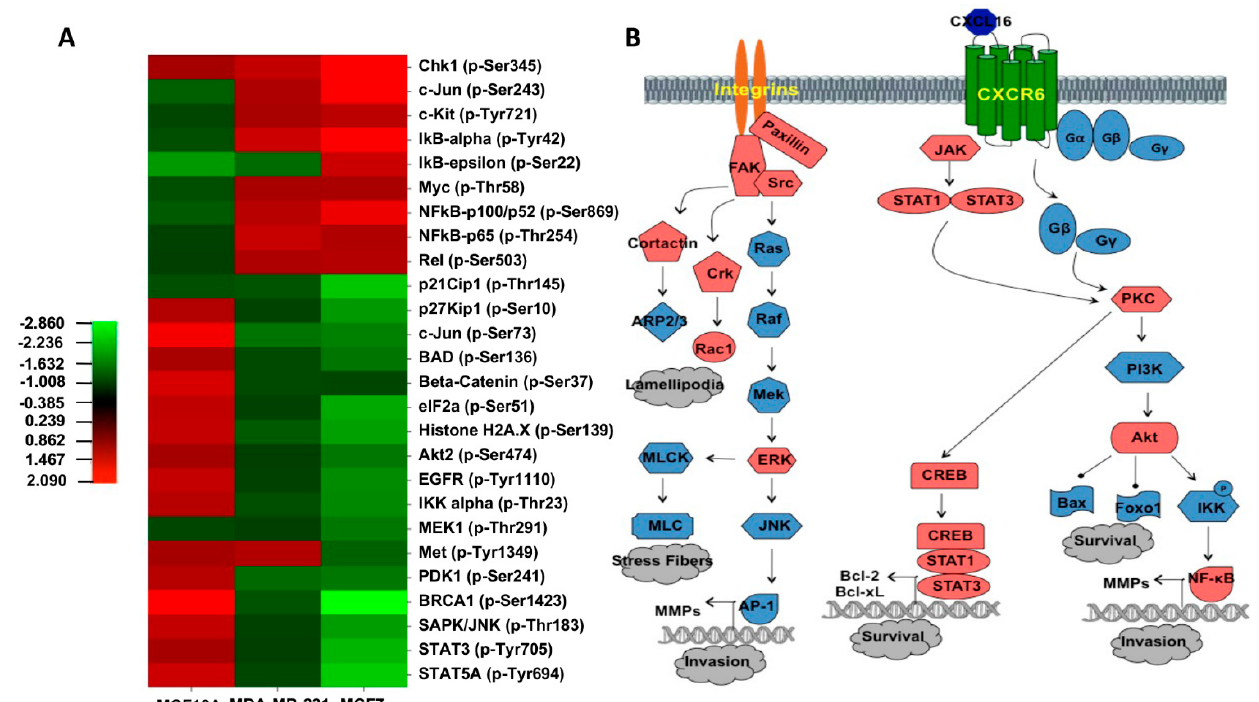
Figure 3. Analysis of CXCR6-mediated phosphorylation of cell signaling molecules using antibody microarray. Phosphorylation-specific antibody array was performed for the qualitative analysis of differentially phosphorylated proteins after treating BrCa cells with CXCL16 (100 ng/mL for 5 min). The BrCa cells treated with vehicle were used as the control. The antibody array consisted of 273 highly specific antibodies against proteins significant for cancer signaling pathways, with β -actin and GAPDH serving as internal positive controls. The median signal intensity for each antibody was obtained using six replicate spots ( n = 6) and was normalized to the median signal of GAPDH. The heat map shown in Panel ( A ) represents a fold change in the phosphorylation status of specified proteins in CXCL16-treated BrCa cells. Heat map was generated from normalized intensity data using the CIMminer tool. Each cell in the heat map shows the ratio of phosphorylated (P) to non-phosphorylated (N) protein in a treated vs. nontreated sample. Red indicates an increase, while green represents a decrease in phosphorylation signaling molecules. The intensity of the color is dependent on the degree of phosphorylation. Panel ( B ) shows the predicted signaling pathway induced by CXCR6-CXCL16 activation leading to neoplastic progression. Changes in the phosphorylation of signaling molecules obtained from antibody microarray analysis were uploaded into Ingenuity Pathways Knowledge Database as text files containing GenBank accession numbers. The chart shows possible activation (red) of the FAK-Src, PI3K/Akt, and Jak/Stat pathways along with the reorganization of the cytoskeleton, which would increase the potential of BrCa cells to survive and invade.